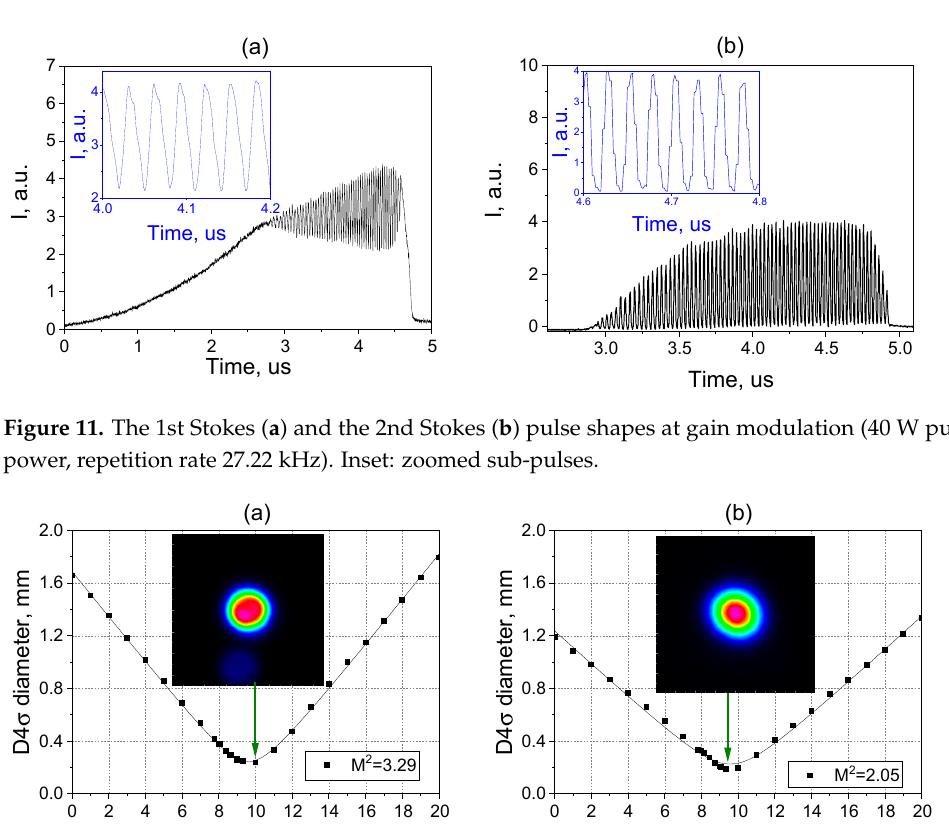
Figure 10. Output spectrum (40 W pump power) in 62.5- μ m GRIN fiber Raman laser with gain modulation. Inset: zoomed 2nd Stokes spectrum with better resolution.